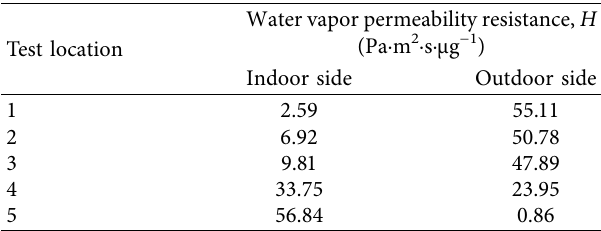
Table 2: The water vapor permeability resistance at the test location of the exterior